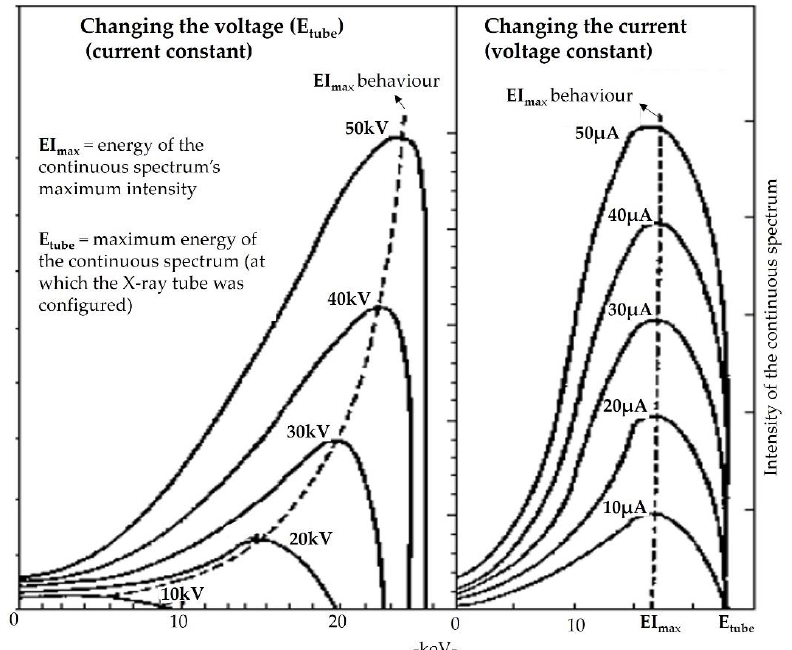
Figure A3. Behavior of the continuous spectrum emitted by the X-ray tube when modifying its voltage (keeping the current constant) and current (keeping the voltage constant) (adapted from Bertin [56]). Based on Figure A3, and using Equation (A1), as suggested by Taggart Jr et al. [57], the energy of the continuous spectrum’s maximum intensity (EI max ) was estimated, in keV, for each X-ray tube configuration.